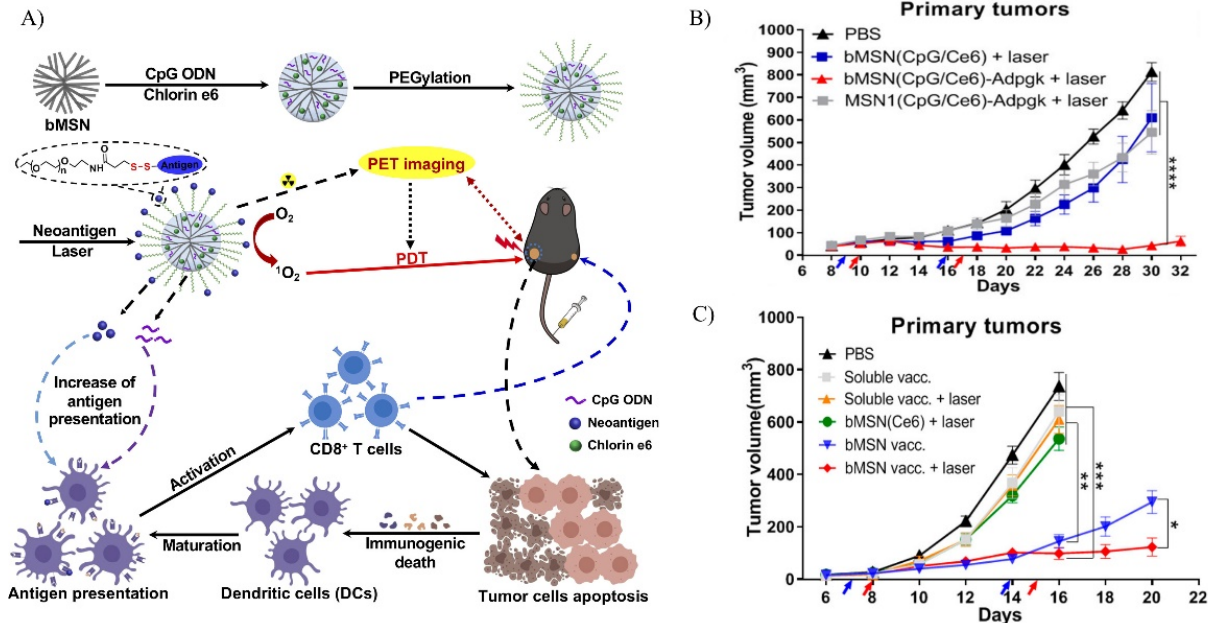
Figure 6. A biodegradable MSN as a platform for dual modality positron emission tomography- guided photodynamic therapy and immunotherapy. ( A ) A schematic of the fabrication of